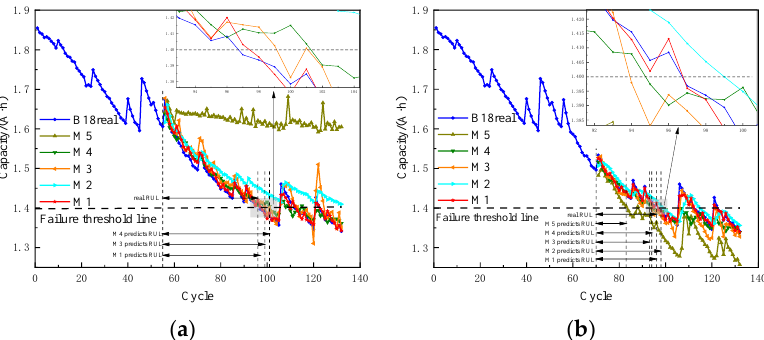
Figure 14. Prediction results of the B7 battery. ( a ) Prediction starting point: 70. ( b ) Prediction starting point: 90.